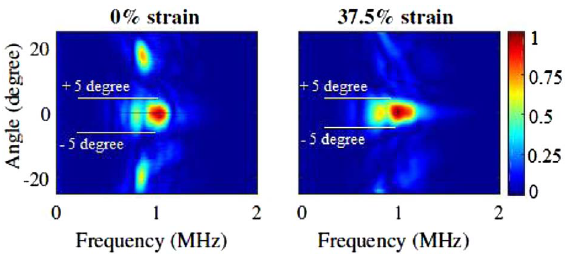
Figure 6. Normalized angular spectrograms were obtained in polar scans about the Y -axis for the sample under 0% and 37.5%